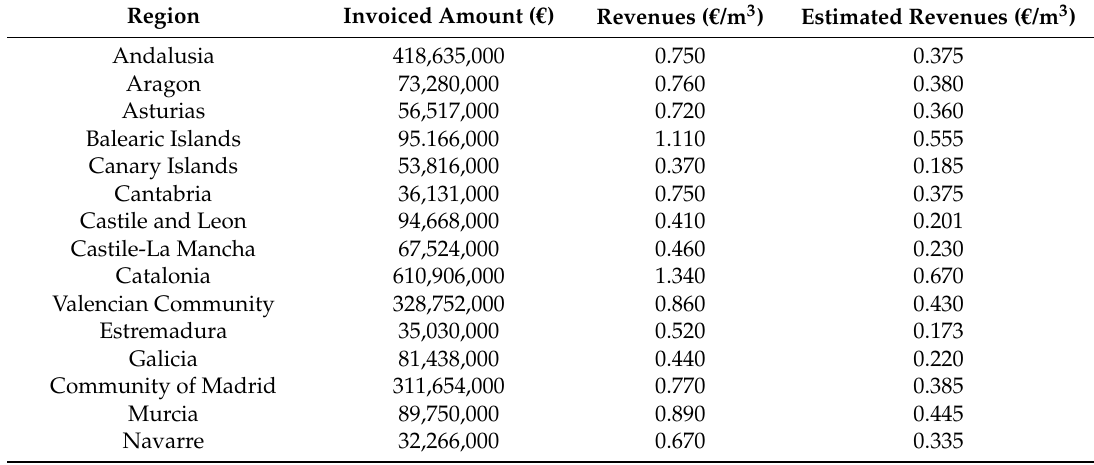
Table 1. Average values collected by sanitation and treatment in the different regions of Spain in